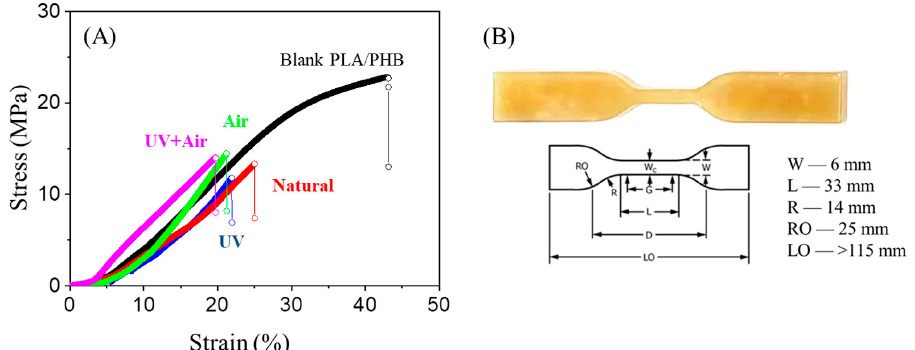
Figure 10. ( A ) Stress–strain curves of dogbone-like PLA/PHB plastics before and after immersion for four weeks in static seawater (Natural), aerated seawater (Air), UV-lighting static seawater (UV), and UV-lighting aerated seawater (UV + Air). ( B ) The dogbone-shaped specimens and their standard physical dimensions (ASTM D638 Standard Test Methods Type IV) for each PLA/PHB plastic were